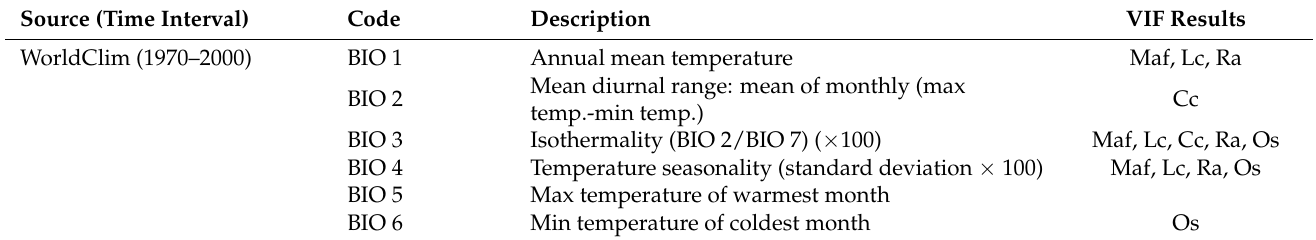
Table 1. Variables used to model habitat suitability of the big five saproxylic beetle species. The results of the variance inflation factor (VIF) stepwise procedure indicate the BIO variables used in the SDM framework for each TU (VIF <